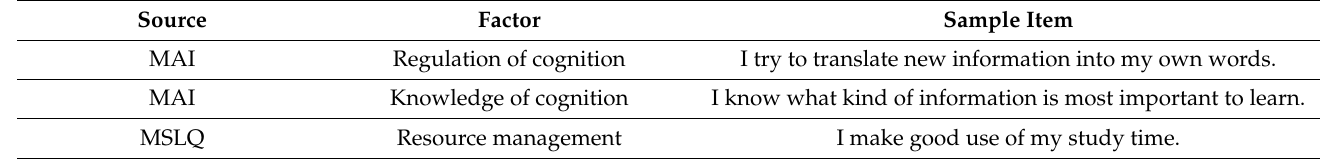
Table 1. Self-regulated learning measures.